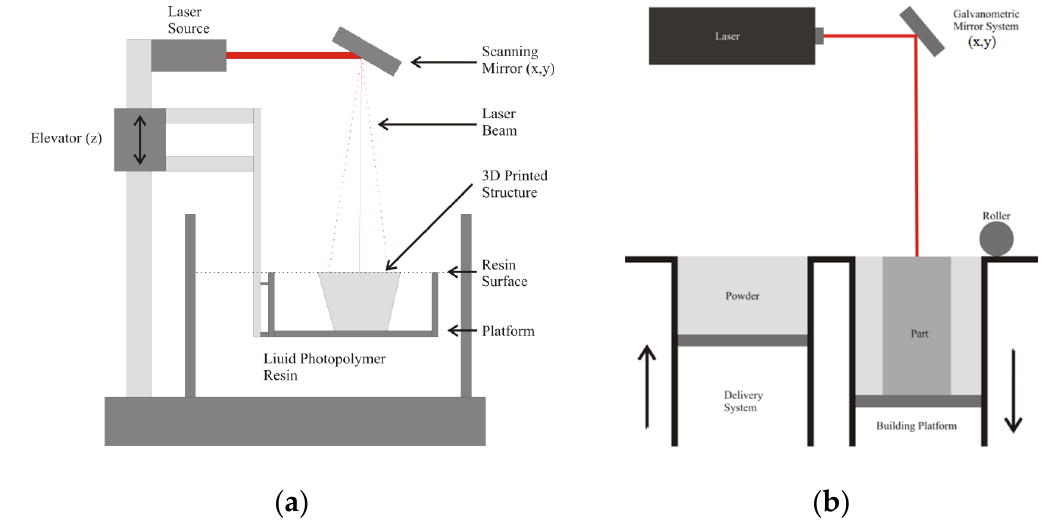
Figure 3. ( a ) Illustration of the Stereolithography system ( b ) Illustration of the Selective Laser Sintering Figure 3 . (a) Illustration of the Stereolithography system (b) Illustration of the Selective Laser Sintering system.